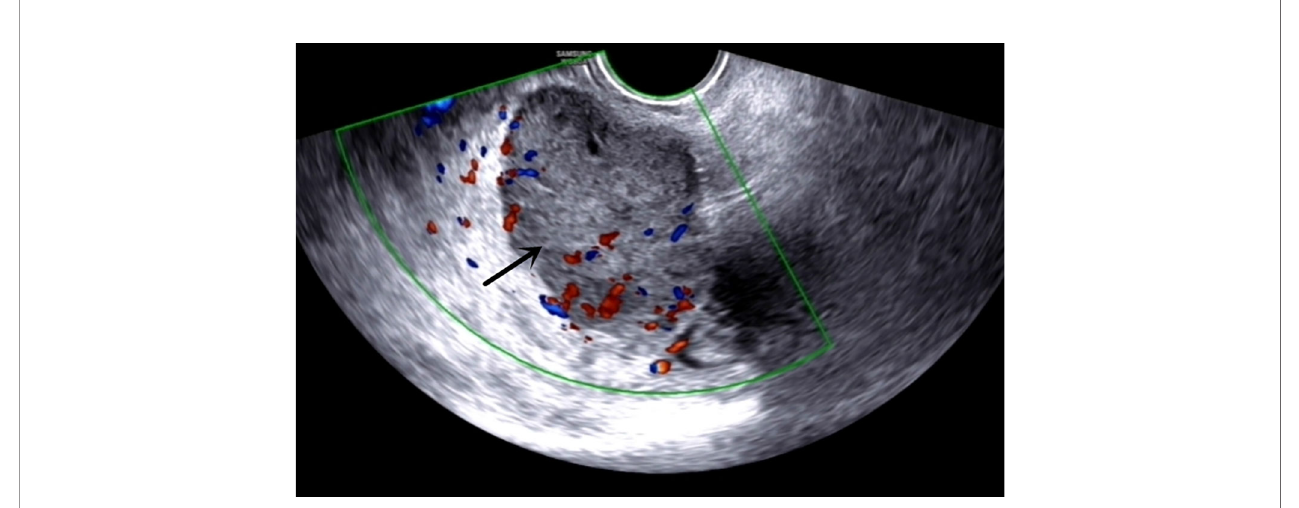
FIGURE 1 | TVS: A 5.1 × 4.6 × 3.7 cm mass can be seen at the right rear of the cervical